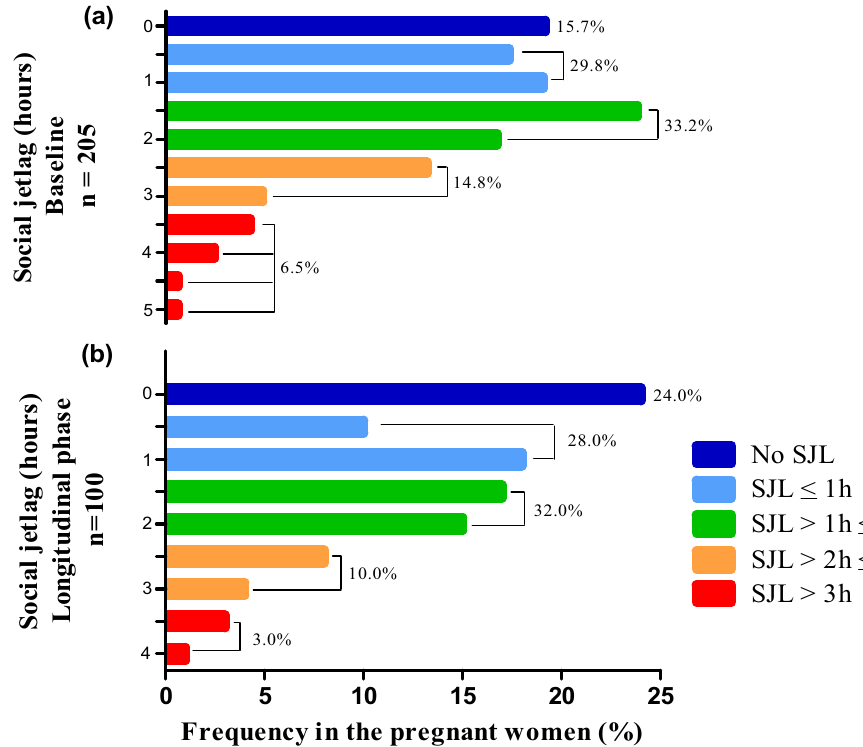
Figure 2. ( a ) Distribution of social jetlag (SJL) of all pregnant women in the baseline (n = 205). ( b ) Distribution of social jetlag (SJL) of all pregnant women in the longitudinal phase (n = 100) in the first trimester. Note : The distribution is based on half-hourly bins. Color-coding is arbitrary and classifies the population into the five SJL groups indicated in the legends. p values were calculated using the Pearson’s chi-square test ( p = 0.379) and are comparative between the first trimester of the two phases of the